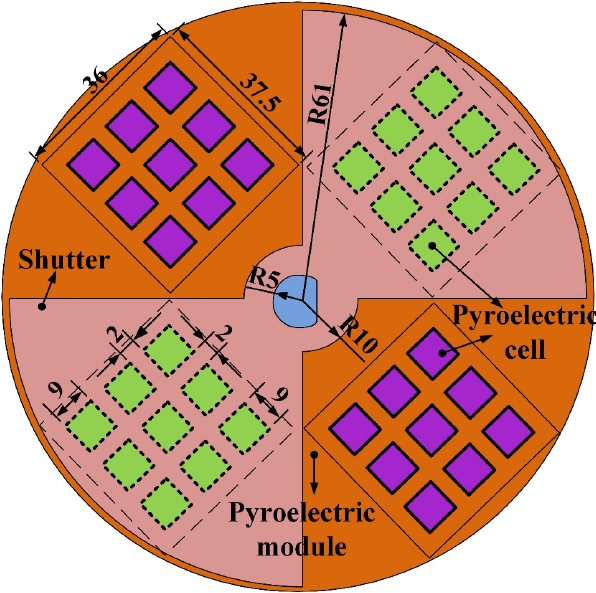
Figure 2. The geometry and the location of the shutter and the pyroelectric cells in the pyroelectric harvester (unit: